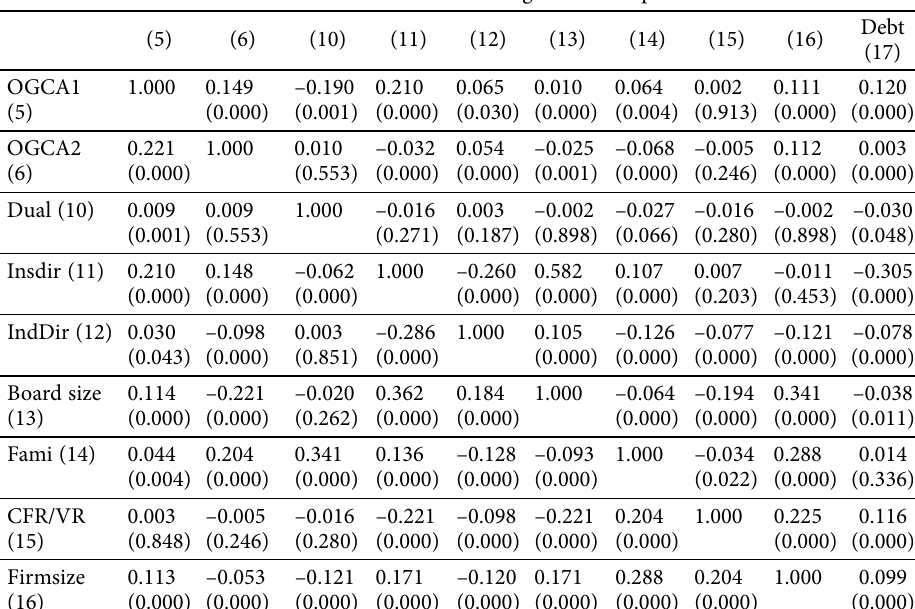
Panel B. Board function and organization